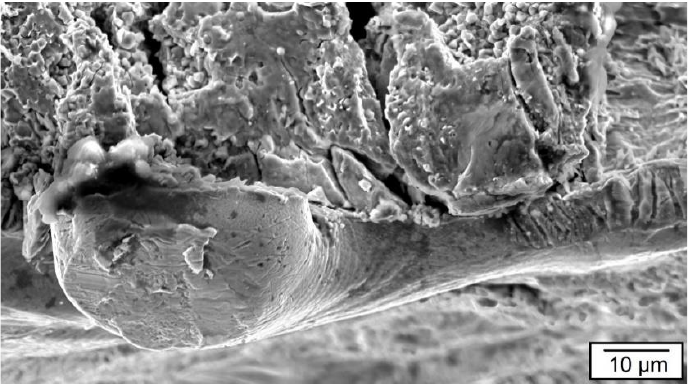
Figure 10. SEM detail image of a melt adhesion showing a melt inflow with a smooth surface, similar to the crack initiation site of the fracture surface for a sample pre-deformed to 44% elongation and subsequently fatigued.